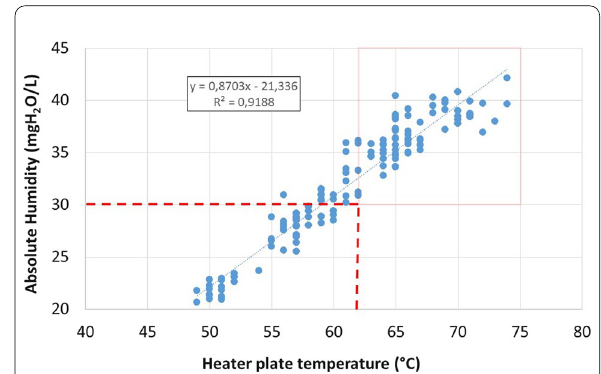
Figure. Relationship between heater plate temperature and absolute humidity delivered by the MR850. When heater plate tempera- ture was above 62 °C, absolute humidity delivered was above 30 mgH2O/L in 100% of the cases. Conclusion: In this bench study, we found a good correlation between heater plate temperature and humidity delivered with heated wire humidifiers MR850 and FP950. With previous generation HH (MR850), humidity delivered is low when ambient temperature is high, as